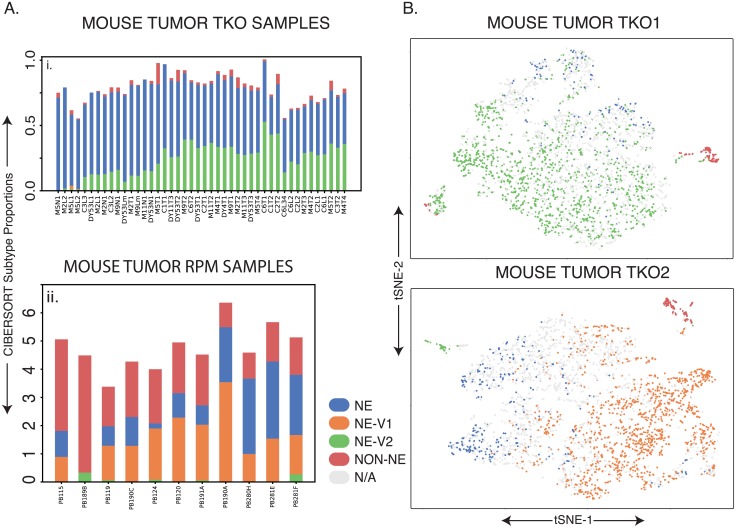
Similar analysis in mouse tumors.A. Ai. TKO (Rb1, Tp53, P130 floxed) mouse tumors showing a high proportion of NE and NEv2 subtypes. Aii. As described in [15], these mouse tumors were generated by crossing Rb1 fl/fl Trp53 fl/fl (RP) animals to knockin Lox-Stop-Lox (LSL)-MycT58A-IRES-Luciferase mice. These Rb1 fl/fl Trp53 fl/fl Myc LSL/LSL (RPM) mice have overexpressed Myc and have been shown to be driven towards a variant phenotype, which is corroborated in this CIBERSORT analysis. It is clear that RPM mice contain greater portions of NEv1 compared to the tumors in Ai., which seems to correspond to the Aurora-Kinase-inhibitor-sensitive, Myc-high phenotype published by Mollaoglu et al. B. t-SNE plots of single cell RNA-seq from two TKO mouse tumors. The k-nearest neighbors (kNN) with k = 10 was computed for each mouse cell to predict subtypes of individual cell using signature genes of each subtype. If at least 8 of the 10 nearest human cell line neighbors for a mouse cell were of one subtype, the cell was assigned that subtype. Large amounts of intratumoral and intertumoral heterogeneity are evident.